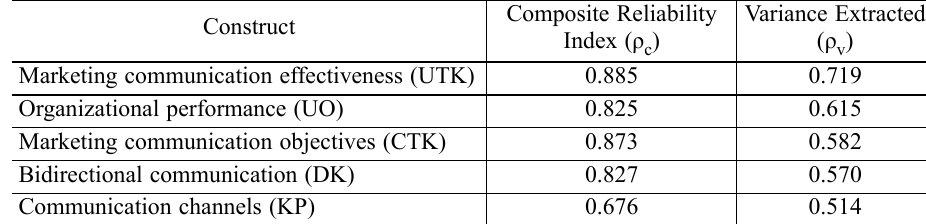
) and variance extracted (ρ c